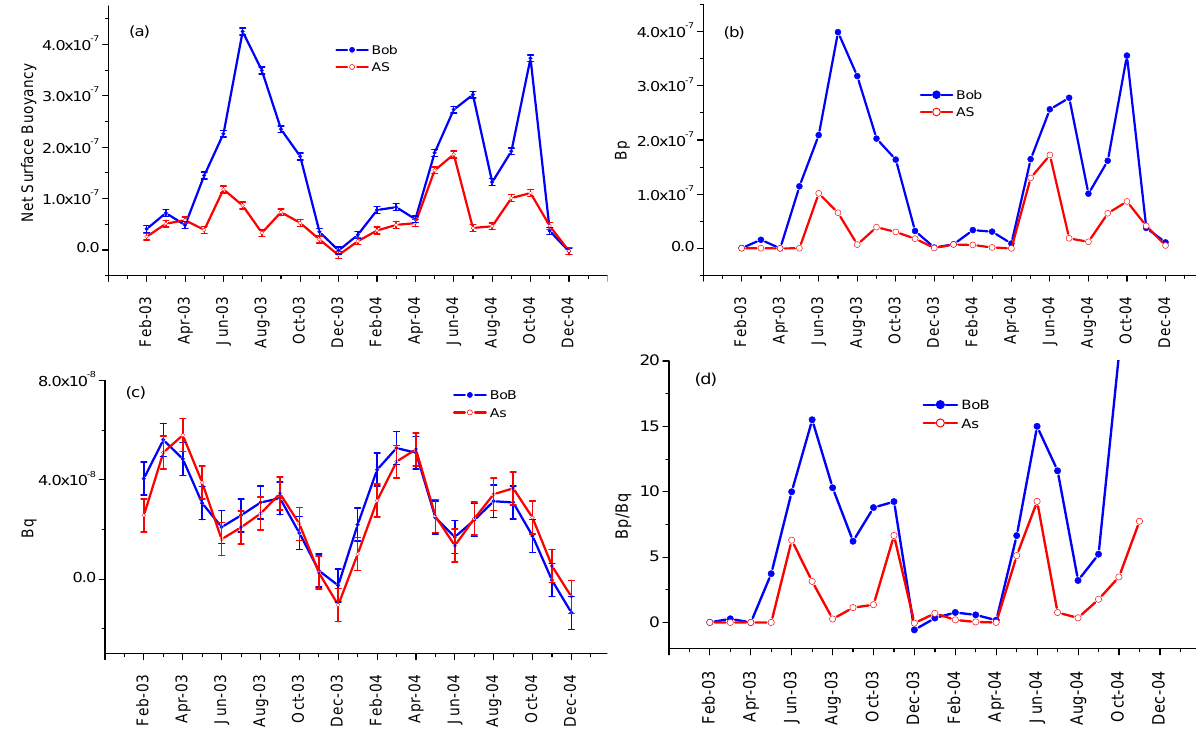
Fig. 2. Time Series of (a) net surface buoyancy with error bars (b) buoyancy due to fresh water B p (c) thermal buoyancy, B q with error bars and (d) ratio of fresh water to thermal buoyancy, B p / B q